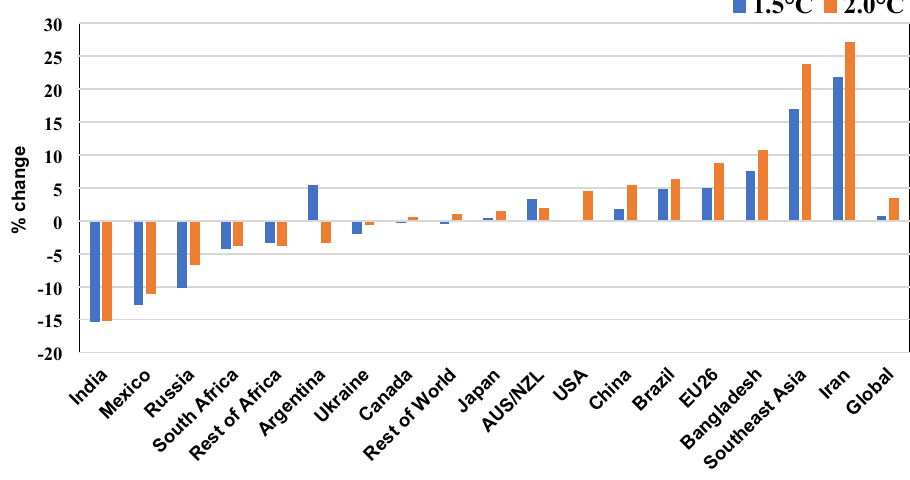
Figure 7. Price change on maize in main continents under global warming by 1.5 °C and 2.0 °C.